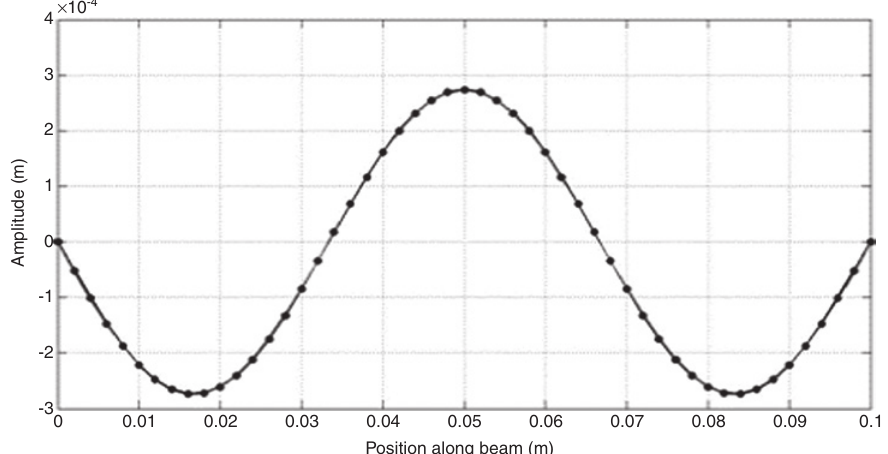
Figure 19: Vibrations of the third characteristic mode of the simply supported